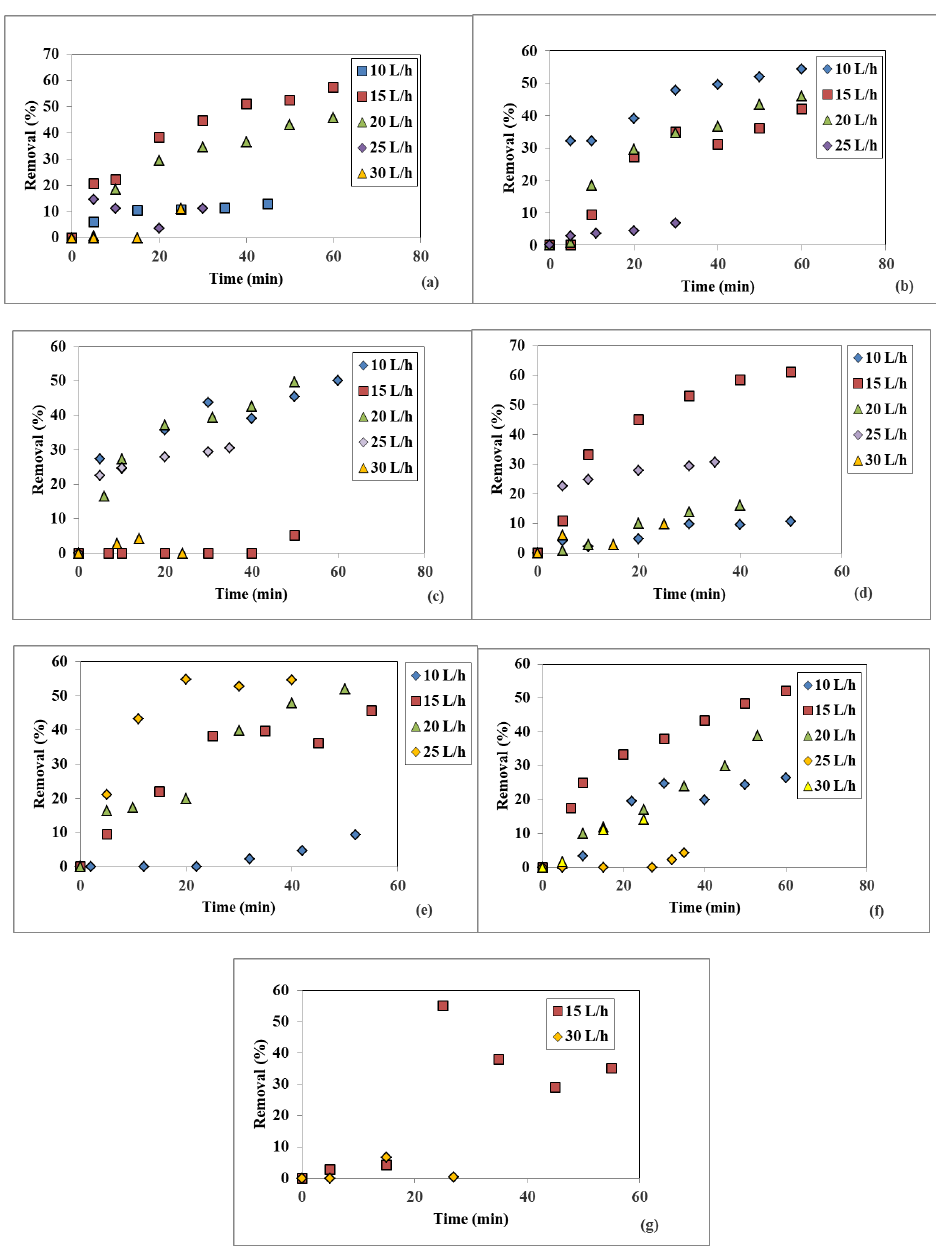
Figure 5. Influence of the WW flowrate on the suspended solids removal at different disc rotational speeds: ( a ) 100 rpm, ( b ) 250 rpm, ( c ) 400 rpm, ( d ) 550 rpm, ( e ) 850 rpm, ( f ) 1200 rpm, ( g ) 1500 rpm.